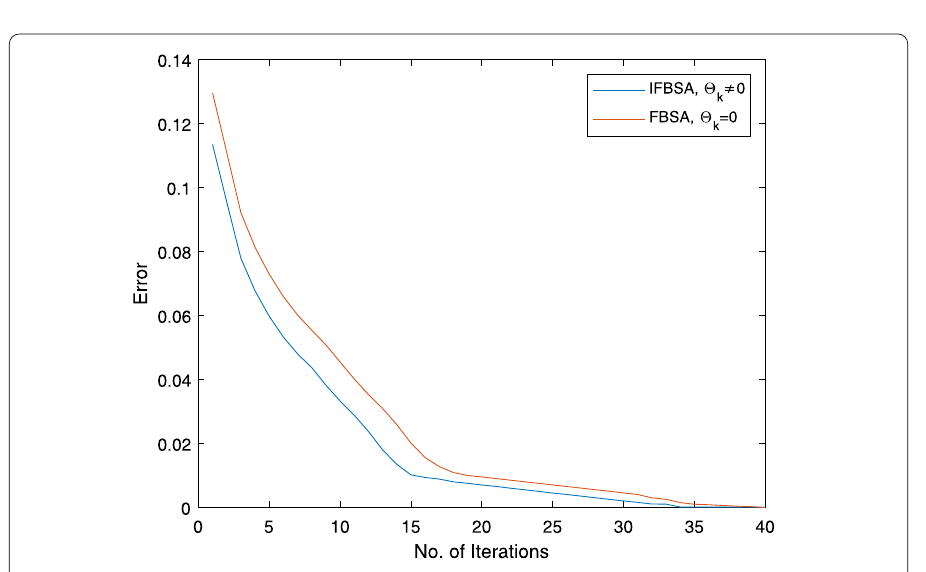
Figure 2 Graph of IFBSA and FBSA plotted for Choice 2 with N =